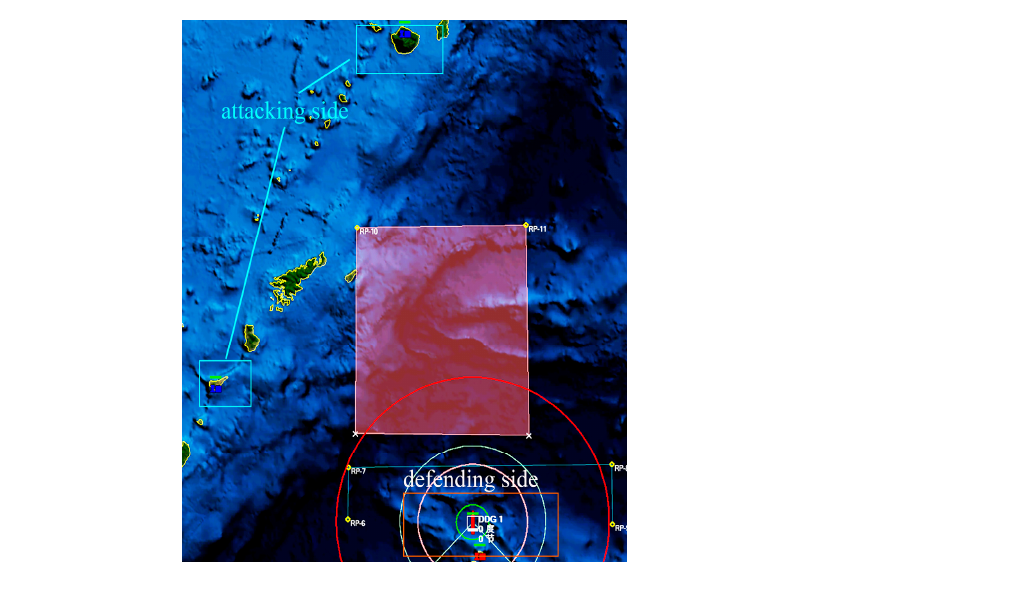
Figure 11. The air-to-sea assault scenario depiction of the attacking side and the defending